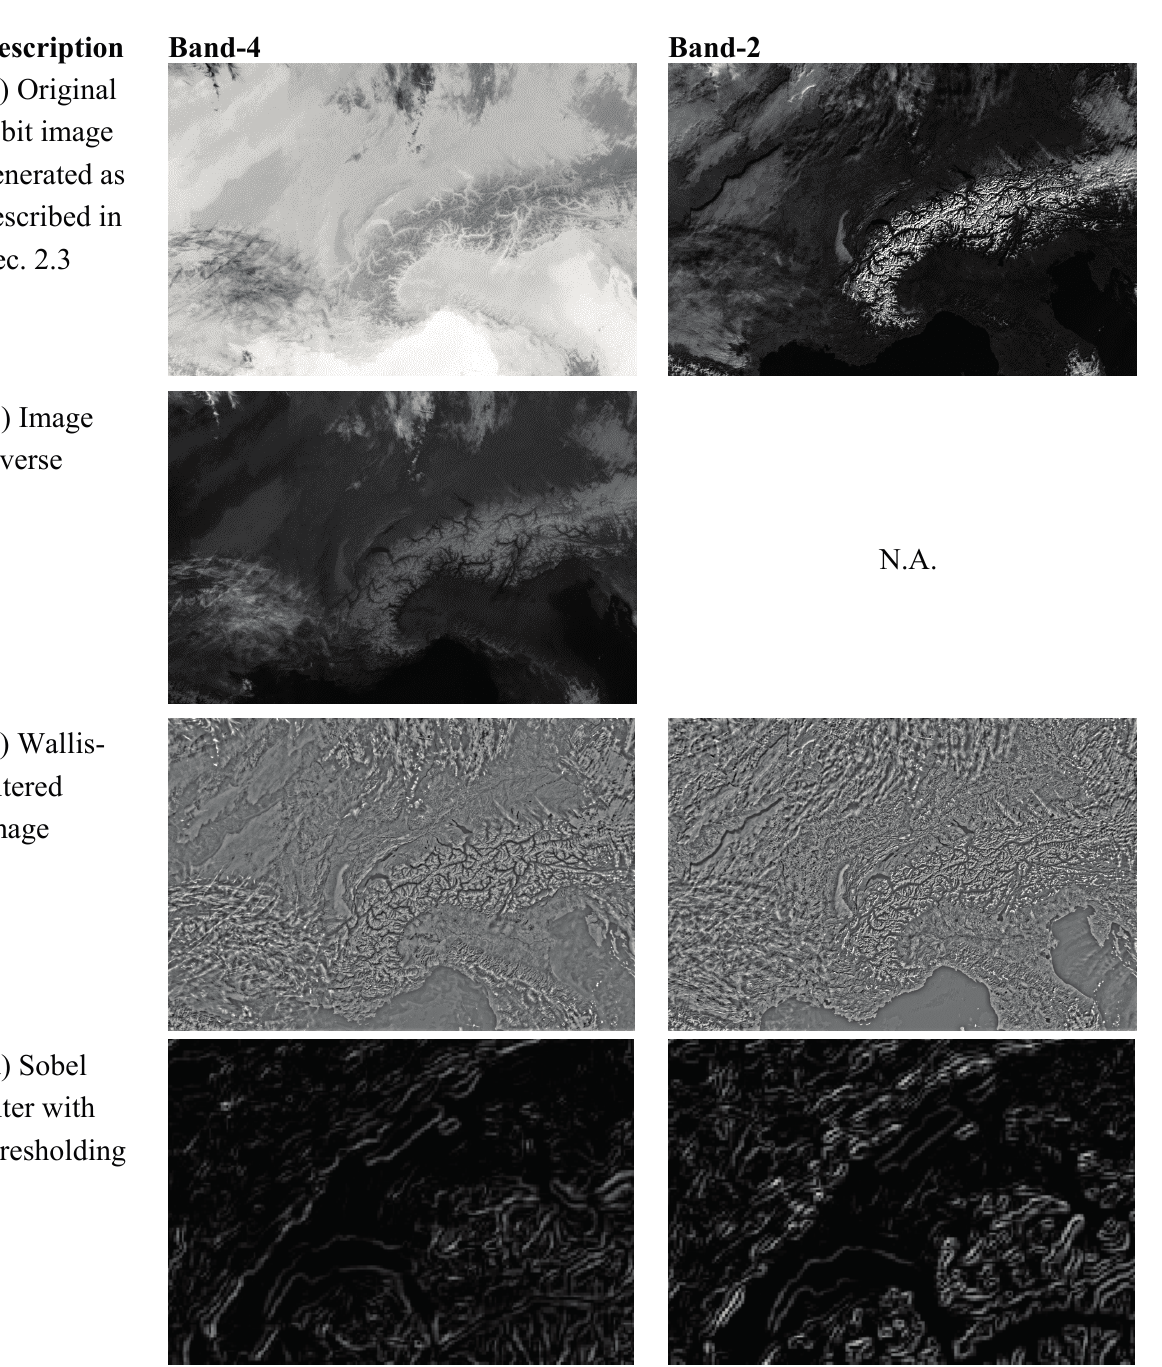
Figure 4. AVHRR Band-4 and Band-2 images acquired from Metop-A on 23 January 2008. ( a ) 8-bit image; ( b ) inverse ; ( c ) Wallis filtered; ( d ) Sobel filtered with